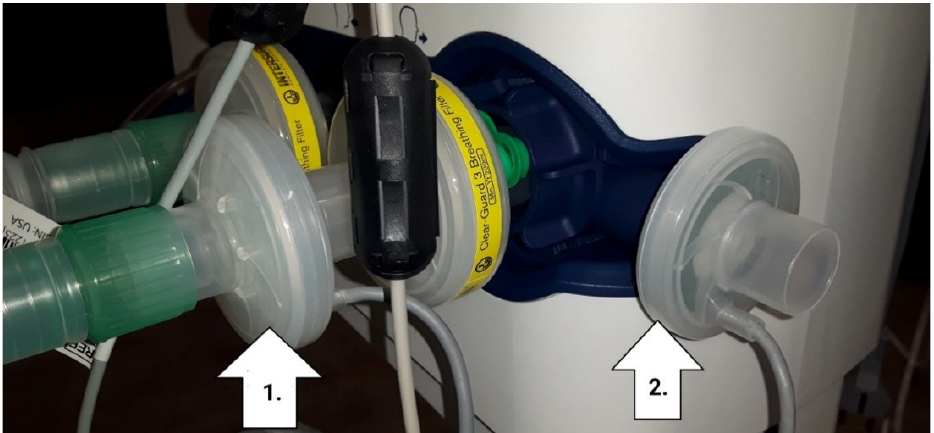
Figure 3. Sensor device placement at the outlet of the mechanical lung ventilation machine (position 2) in a real operating condition in a hospital setting, which was adopted. Another potential location (position 1) of the breath contour before the ventilation machine was also evaluated.